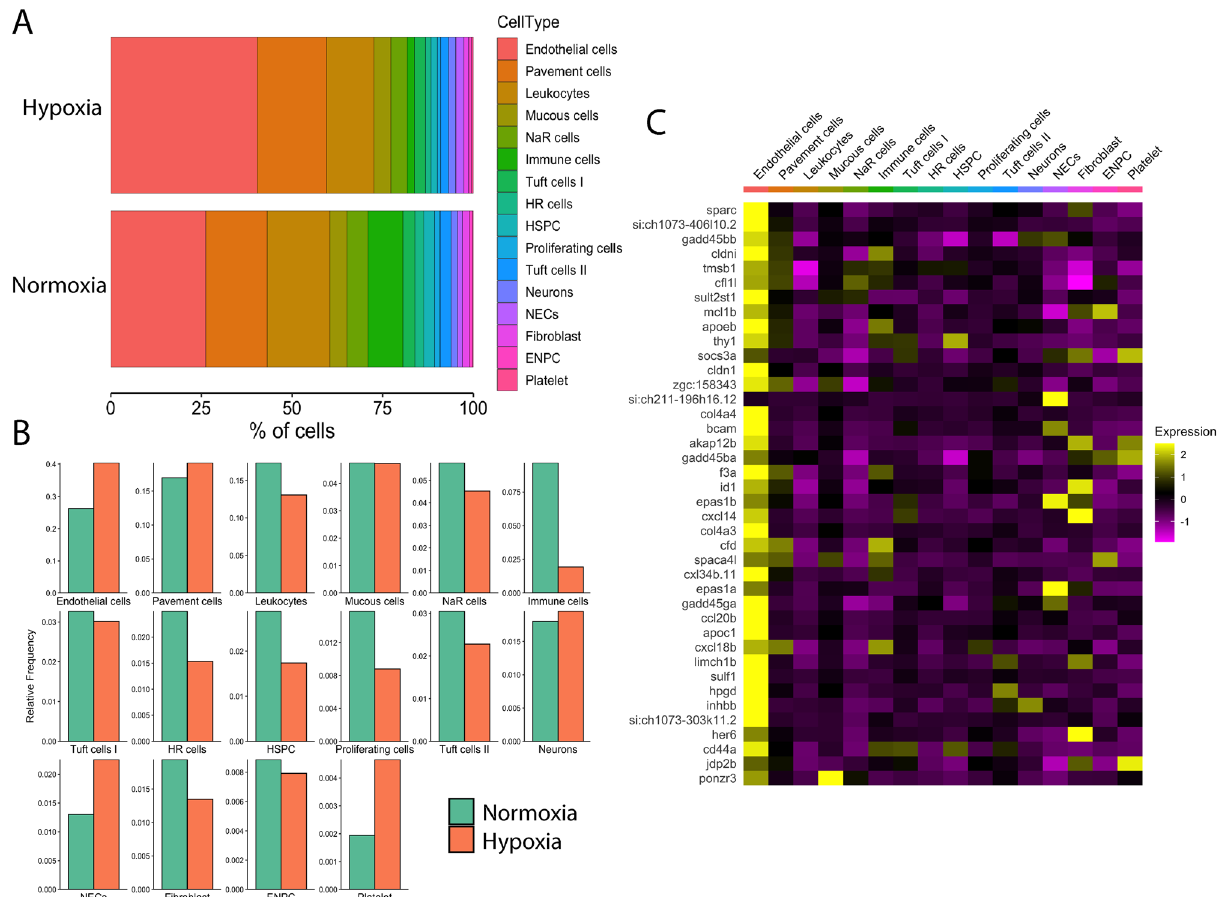
Figure 6. Effects of chronic hypoxia on gill cell composition and global gene expression. ( A ) Stacked bar graph shows the relative difference in % cell composition between normoxic and hypoxic conditions. Cell types are coded by colour and are indicated at the right. ( B ) Bar graphs showing changes in relative cell frequency in normoxia (green) vs. hypoxia (orange) in each cell cluster. ( C ) Heatmap showing the distribution of the top 40 highly differentially expressed genes in chronic hypoxia compared to normoxia. Scaled gene expression is shown by colours, where yellow indicates relatively high expression and purple indicates relatively low